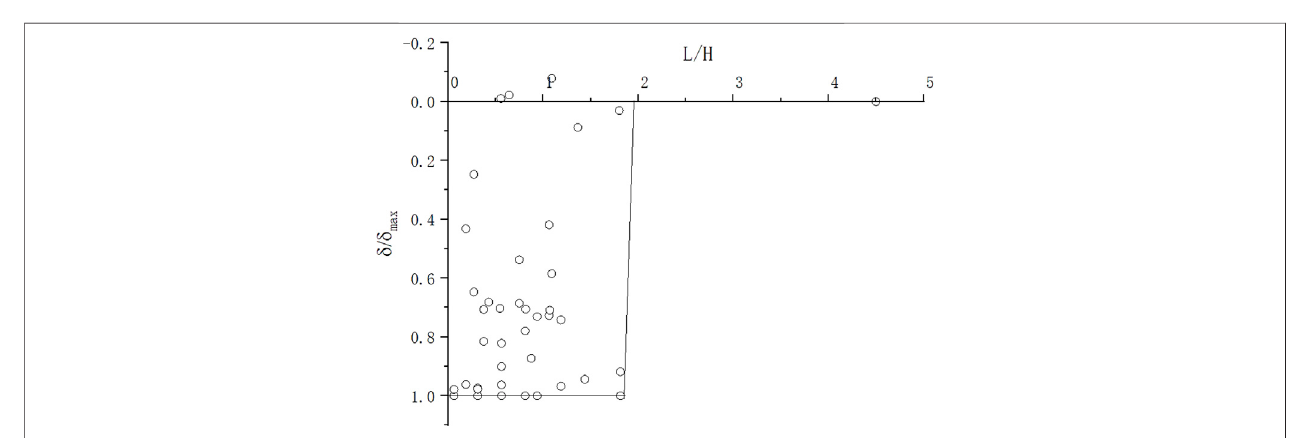
FIGURE 9 | δ / δ max − L / H relationship.